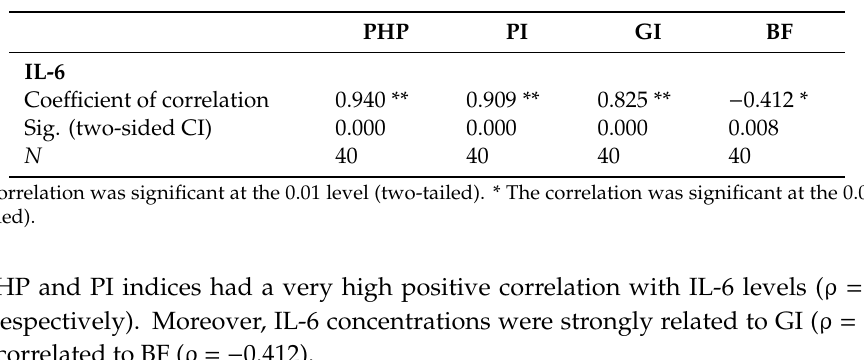
Table 4. Spearman’s ρ test between IL-6 and all oral